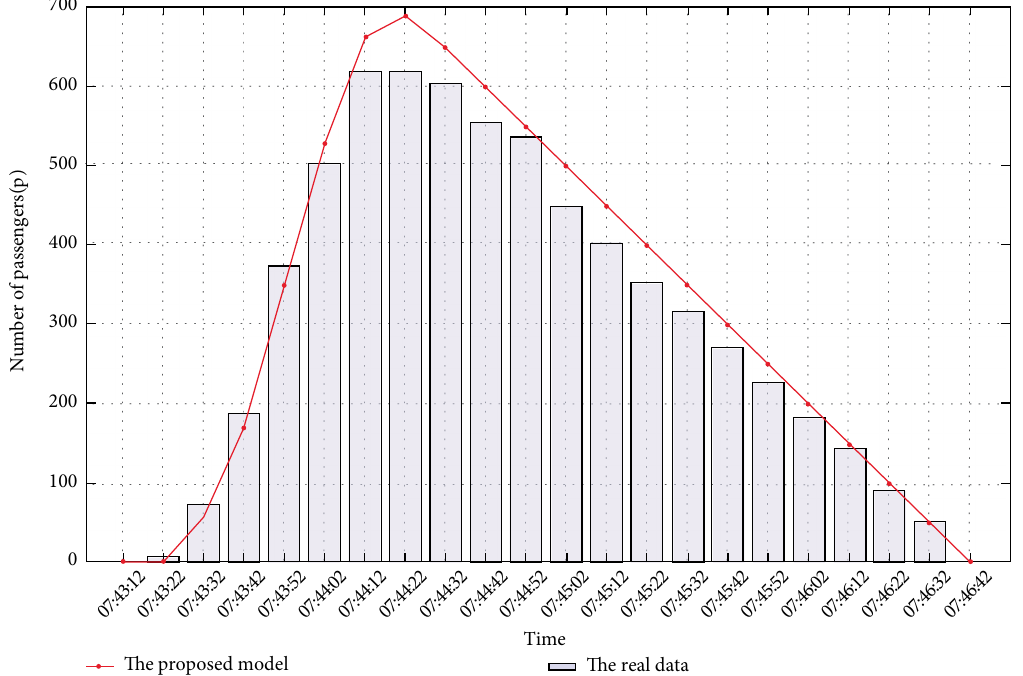
Figure 13: The number of passengers for the process of leaving